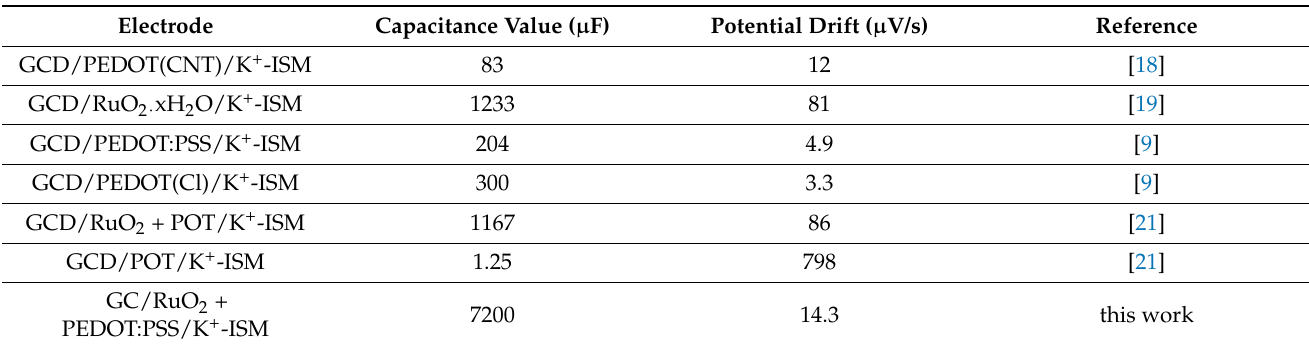
Table 1. Electrical and potentiometric parameters compared for a group of coated-disc electrodes (GCD)/ solid-contact (SC)/K + -ISM electrodes with various materials applied as solid-contact (SC) layers. Electrode Capacitance Value ( µ F) Potential Drift ( µ V/s) Reference GCD/PEDOT(CNT)/K + -ISM